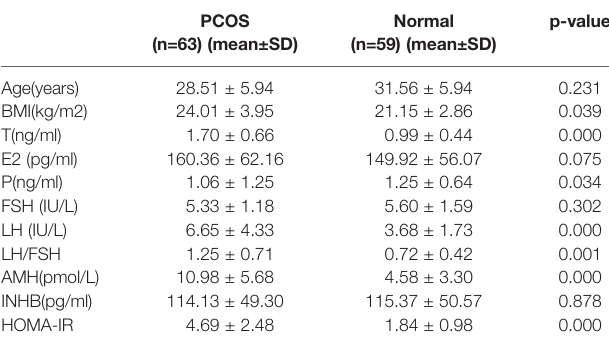
TABLE 1 | The clinical characteristics of PCOS patients and normal